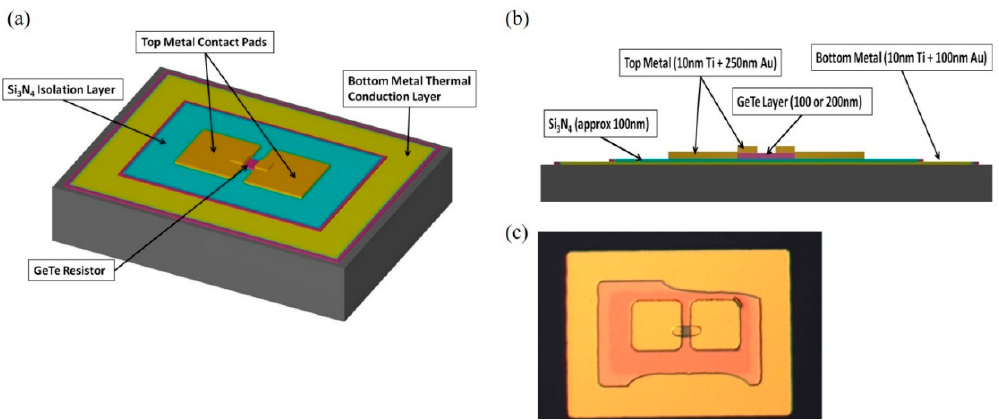
Figure 2. GeTe horizontal resistor designs: L-Edit ( a ) top; and ( b ) side view of a resistor; ( c ) optical microscope image of a resistor with 5 µm inter-electrode distance.